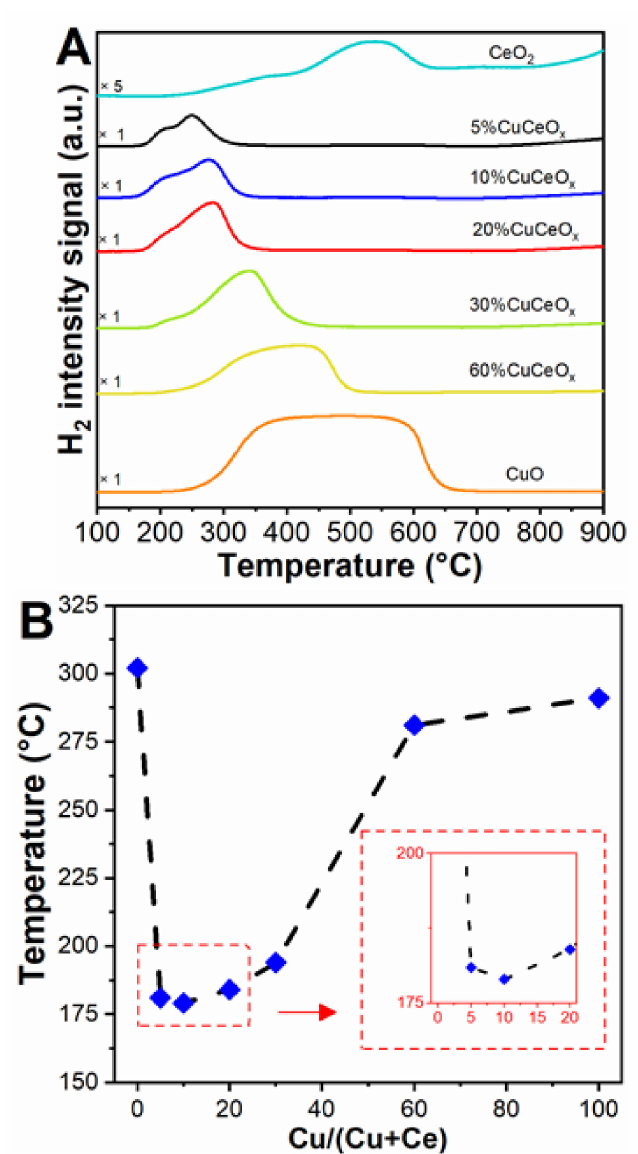
Figure 6. ( A ) H 2 -TPR profiles of the CuCeO x catalysts. ( B ) Trend in the position of the low- temperature reduction peaks as a function of the Cu content in the different